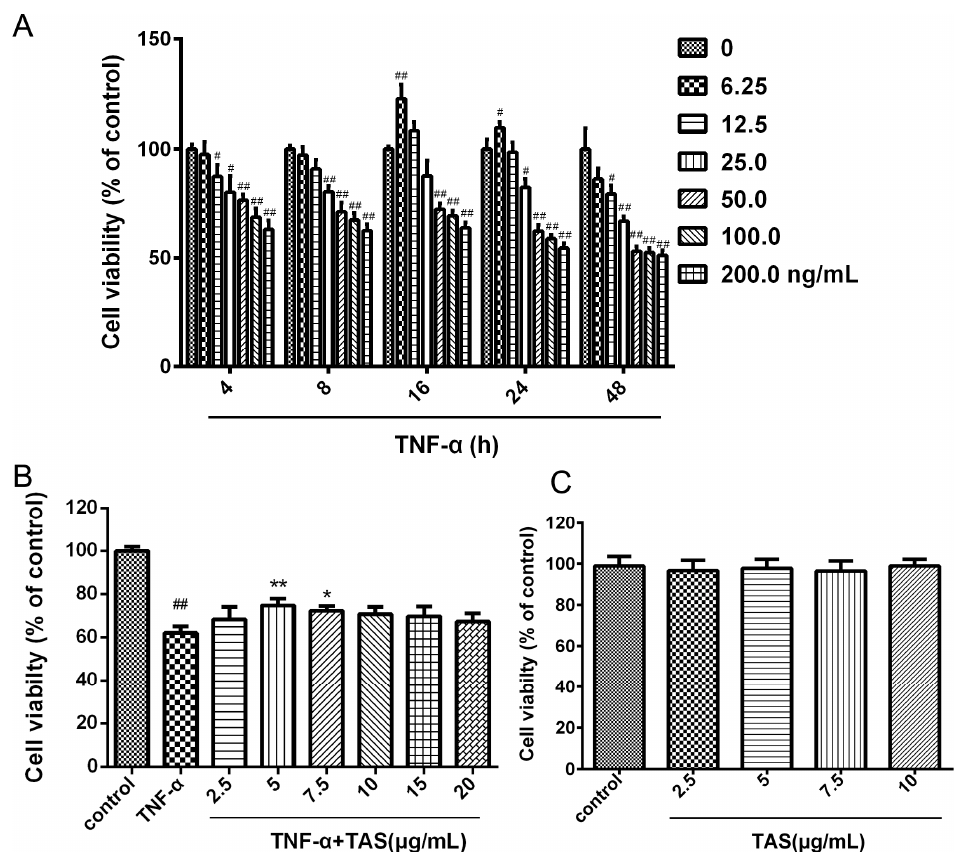
Figure 1. Total saponins of Aralia elata (Miq.) Seem. (TAS) protected human umbilical vein endothelial cells (HUVECs) against tumour necrosis factor (TNF)- α -induced injury. ( A ) HUVECs were incubated with TNF- α at different concentrations for various times (4, 8, 16, 24 and 48 h). Cell viability was determined using the MTT assay. ( B ) HUVECs were pretreated with TAS (2.5, 5, 7, 5, 10, 15 and 20 µ g/mL) for 2 h, followed by treatment with TNF- α (50 ng/mL) for 24 h. Cell viability was measured using the MTT assay. ( C ) TAS administration alone showed no toxic effect. The data are presented as the mean ± SD of three independent tests. # p < 0.05, ## p < 0.01 versus the control group; * p < 0.05, ** p < 0.01 versus the TNF- α -incubation group.